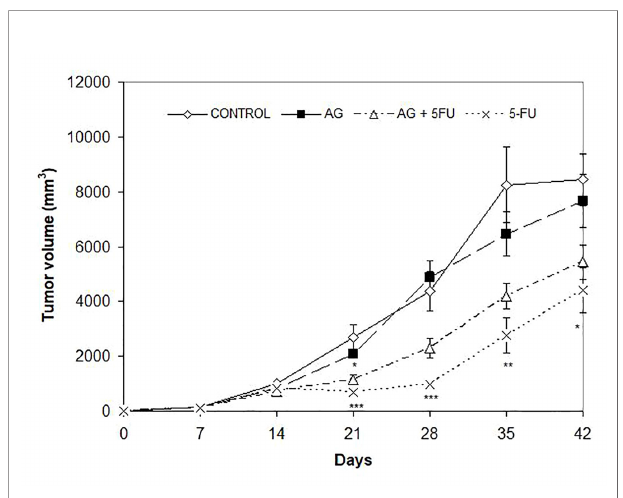
FIGURE 3 | Effect of Agarikon.1 (AG), 5- fl uorouracil (5-FU), and their combination on tumor volume. Treatment started 14 days after s.c. inoculation of CT26.WT (1×10 6 /mouse) cells with 1200 mg/kg of Agarikon.1 by oral gavage during 14 days continuously, or with 5-FU intraperitoneally at dose of 30 mg/kg on days 1.-4. and 15 mg/kg on 6., 8., 10., and 12. day of treatment. Volumes were determined once weekly for six weeks. * p <; 0.05; ** p < 0.01; *** p < 0,001, versus control group. Bars show means ±